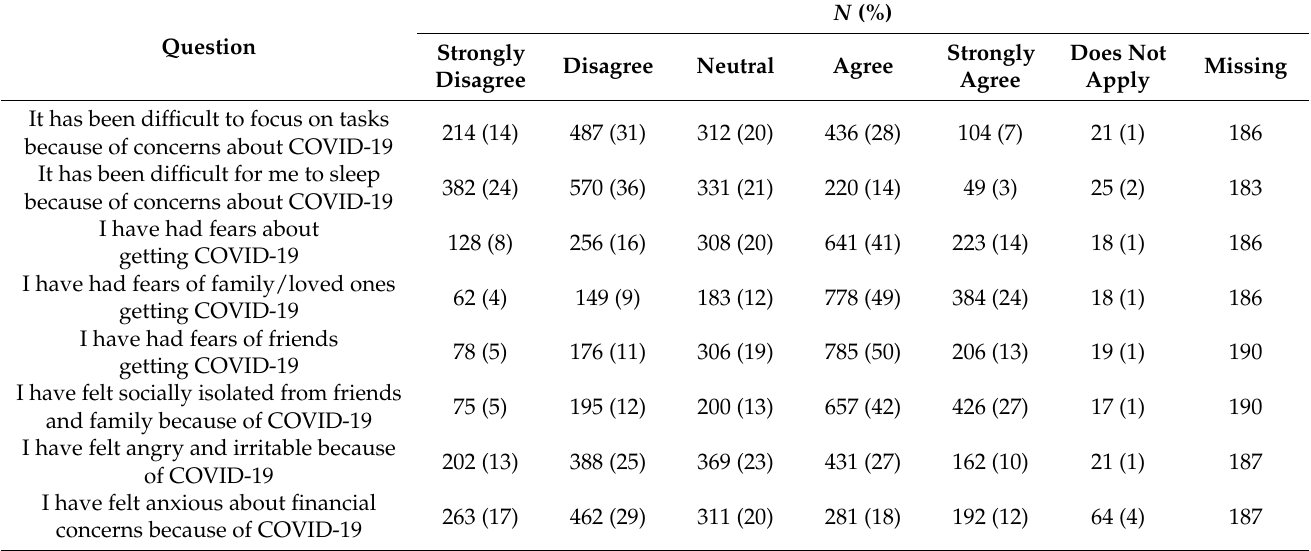
Table 5. Psychological impact of